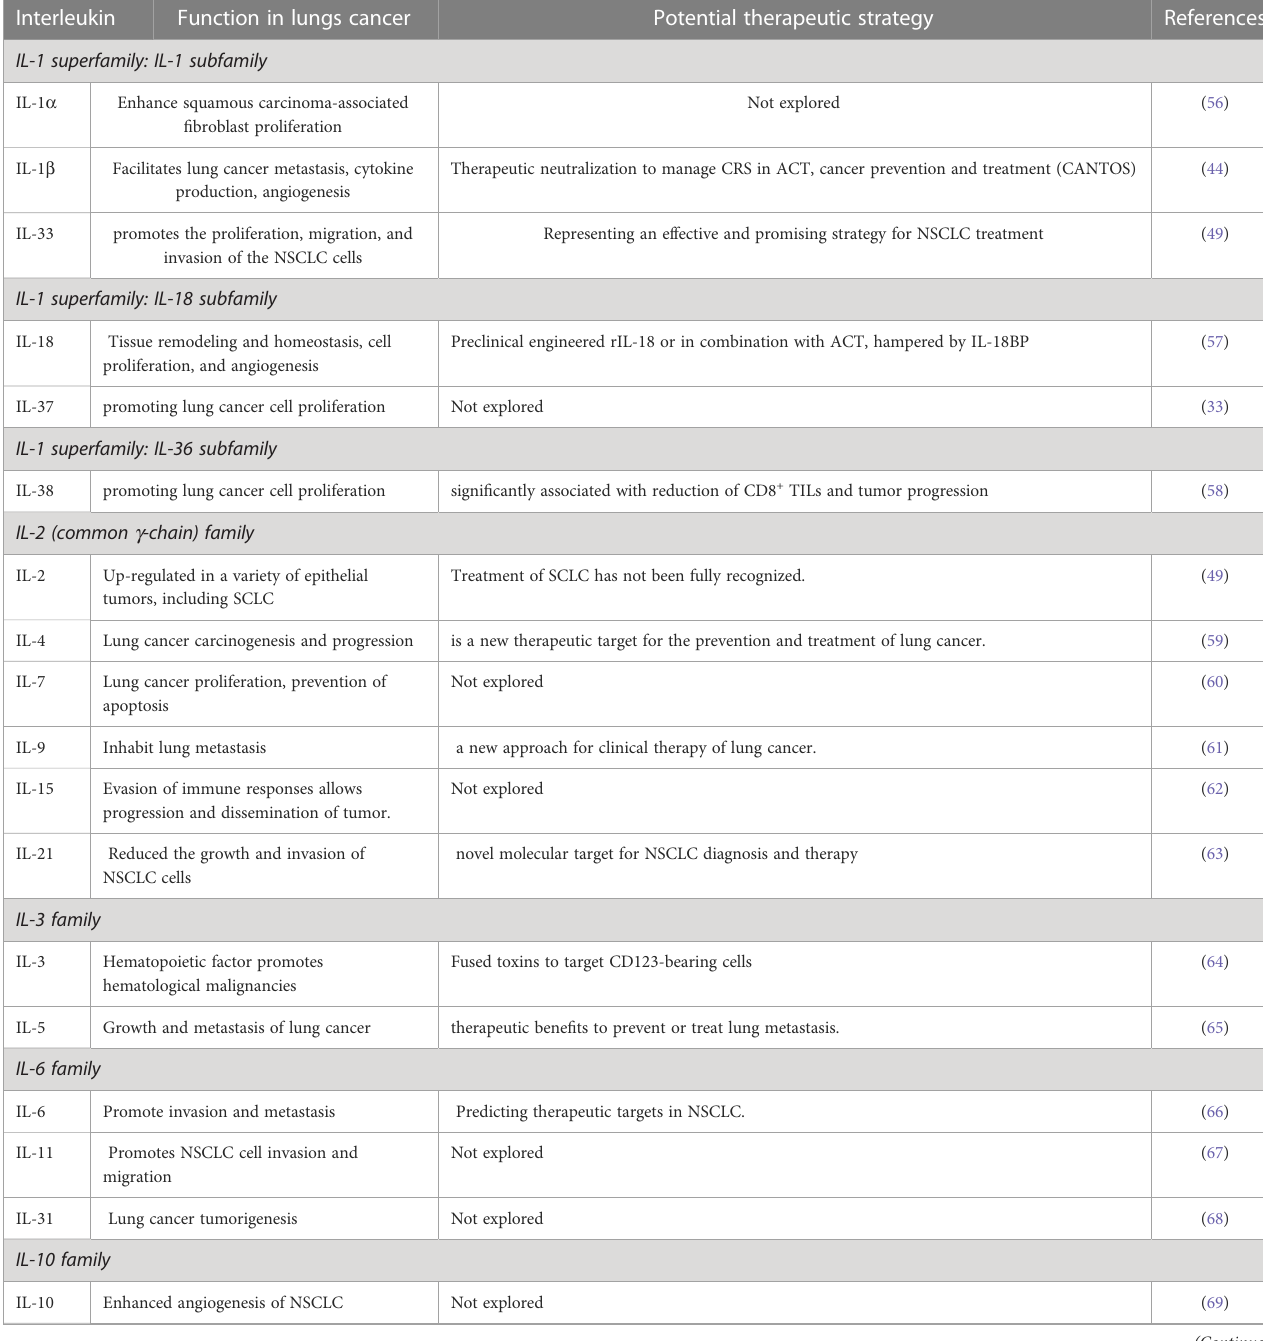
TABLE 1 Serum interleukin families ’ importance and function in lung cancer. Interleukin Function in lungs